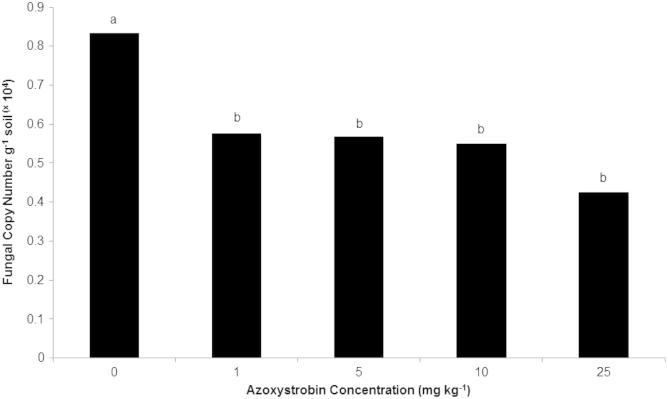
Average fungal copy numbers recorded for soils exposed to different Azoxystrobin concentrations 1 month prior to sampling. LSD = 0.223. Each copy number value represents the mean of 4 experimental replicates. Different letters denote significant differences between treatments.